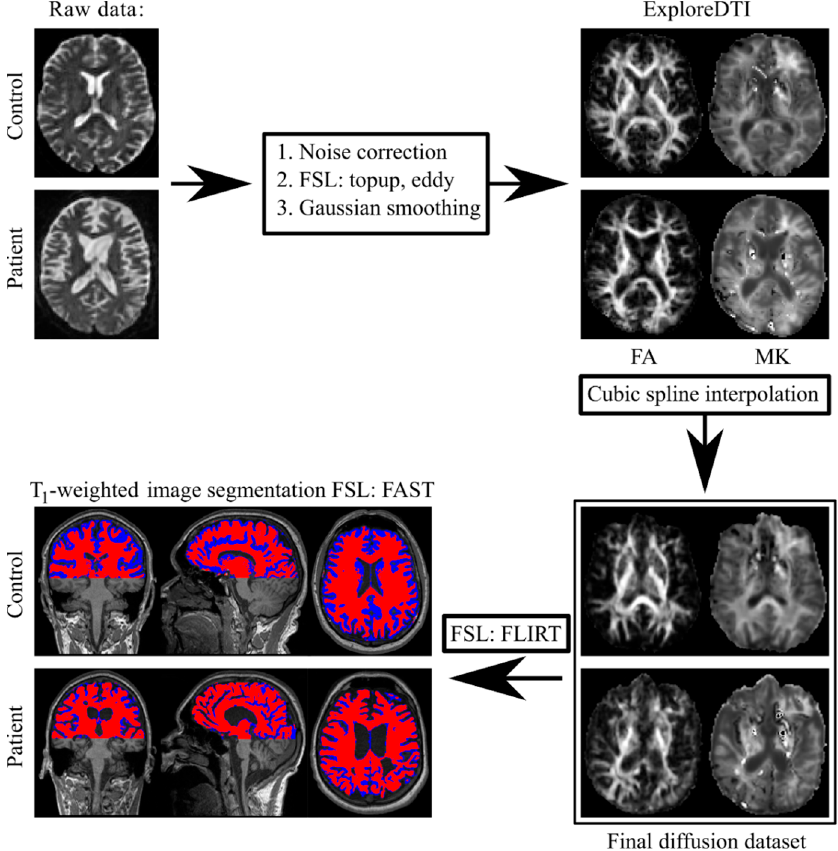
Figure 2. Schematic representation of the diffusion post-processing procedure.